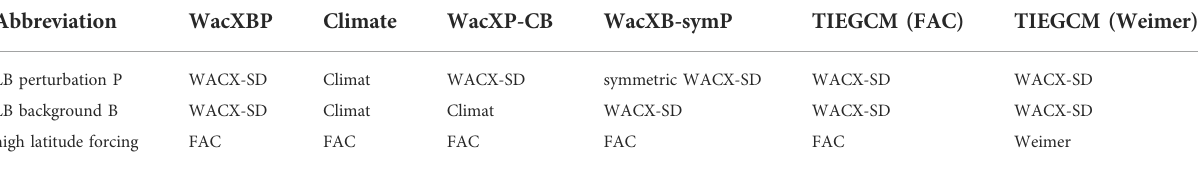
TABLE 1 Overview of simulation set up: all simulations are done with the TIEGCM; the simulations WacXBP and TIEGCM(FAC) are the same and the former abbreviation is used in section 3 highlighting the lower boundary forcing and the latter in section 4 focused on the high latitude